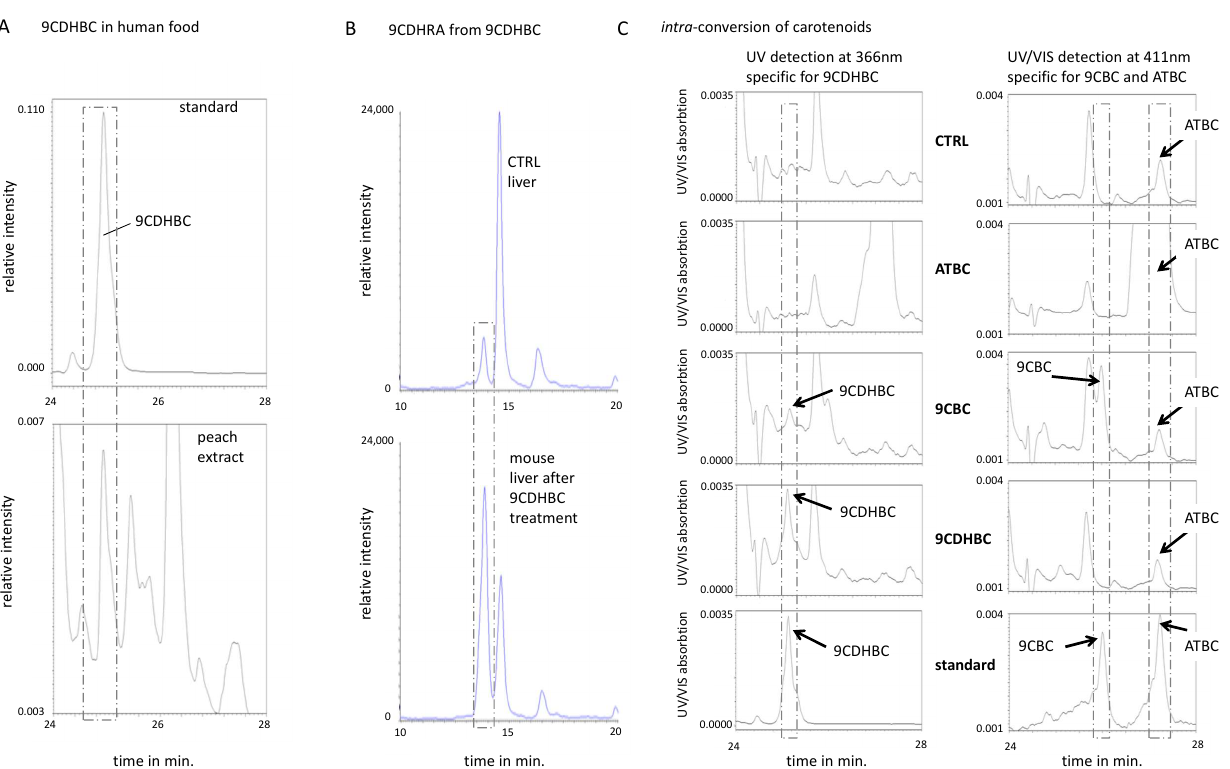
Figure 4. The provitamin A5/X concept, 9CDHBC as a 9CDHRA precursor. ( A ). 9CDHBC in the human food chain: standard of 9CDHBC eluting at 25.0 min (upper panel) and extract from canned peach (bottom panel) with a peak co-eluting at 25.0 min (indicated by a dashed line box) displayed with y -axis scale of relative intensity in 405 -> 95 m / z and a comparable UV/VIS spectrum (data not shown). ( B ). Conversion of 9CDHBC to 9CDHRA: 9CDHRA (indicated by a dashed line box) and ATDHRA (all- trans -dihydroretinoic acid) as peak eluting after 9CDHRA standard level after control-treatment (CTRL, physiological-relevant value, top chromatogram) and after 9CDHBC-supplementation (bottom chromatograms) in mouse liver (§). ( C ). Intra-conversion of carotenoids: left panel, indicating conversion of administered 9CBC to 9CDHBC in human oligodendrocyte cell line in vitro. Dashed line box indicates a peak with a retention time of 25.1 min of 9CDHBC standard and present after 9CDHBC treatment (fourth figure from the top at the left panel) as well in lower levels after 9CBC treatment (third figure from the top at the left panel), all detected at 366 nm and the same Y -axis. Right panel indicates no conversion of ATBC to either 9CBC or 9CDHBC in oligodendrocyte human cell line in vitro . ATBC is eluting at 27.2 min (detectable at 411 nm, while having an UV max of 450 nm and indicated by a dashed line box and with the same y -axis) and present at very high levels after ATBC-treatment (second figure from the top at the right panel). 9CBC (indicated by a dashed line box) is present as a major shoulder peak after 9CBC-treatment, being non-detectable after CTRL or alternative